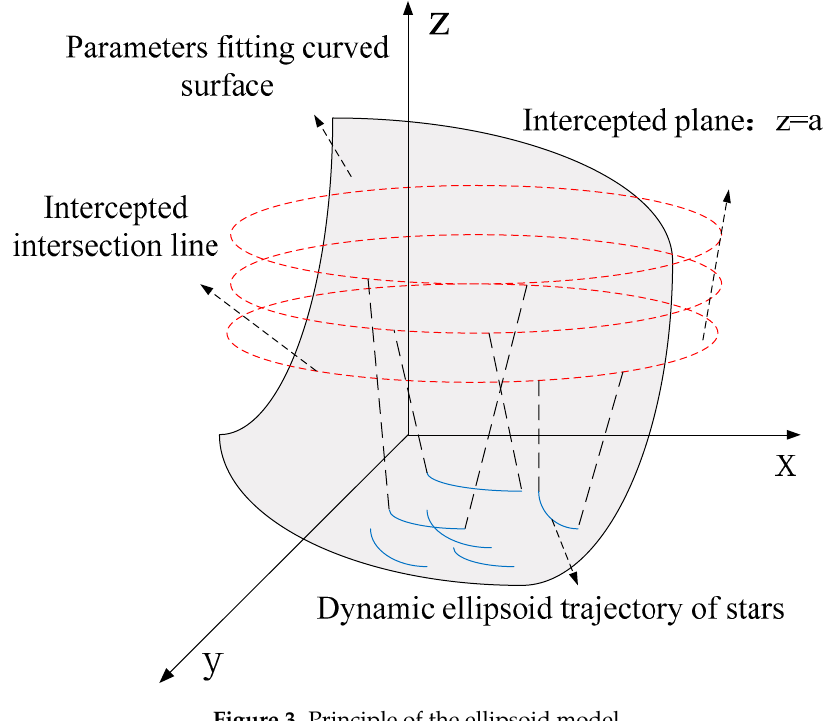
Figure 3. Principle of the ellipsoid model.